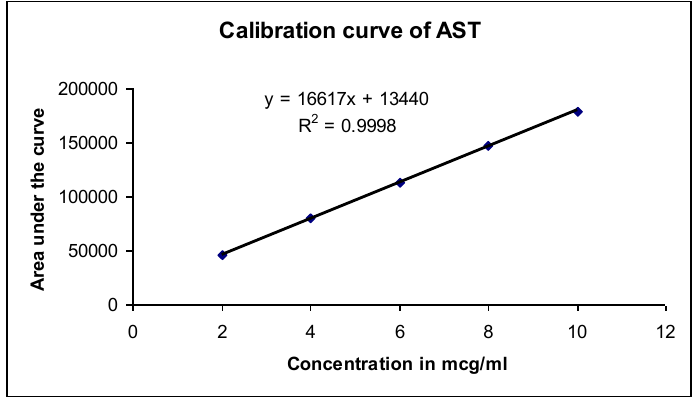
Figure 2. Linearity graph of Atorvastatin calcium (AST).